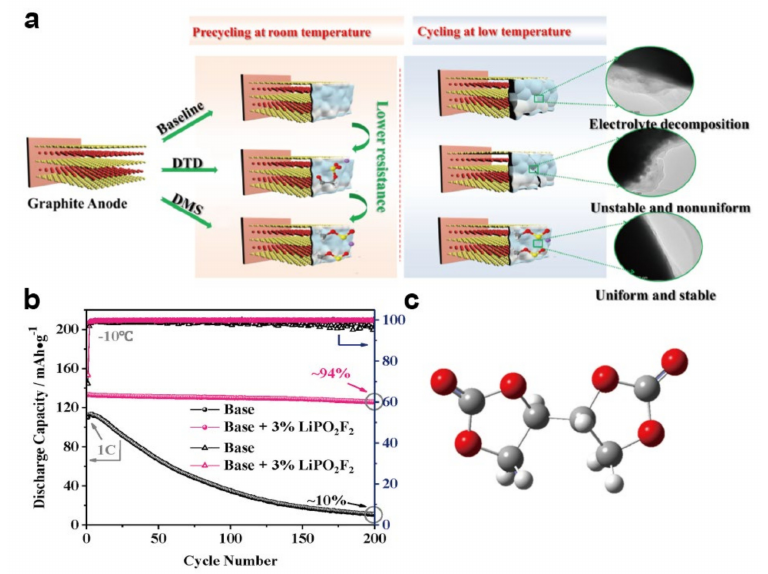
Figure 8. ( a ) Schematic diagram of the SEI on a graphite anode in an electrolyte with different additives [144]. Reproduced with permission from ACS Applied Materials & Interfaces; published by American Chemical Society, 2019; ( b ) cycling performance of NCM/Li in electrolyte with and without LiPO 2 F 2 [145]. Reproduced with permission from Electrochimica Acta; published by Elsevier Ltd., 2018; ( c ) molecular structure of EBC [148]. Reproduced with permission from Energy Storage Materials; published by Elsevier,